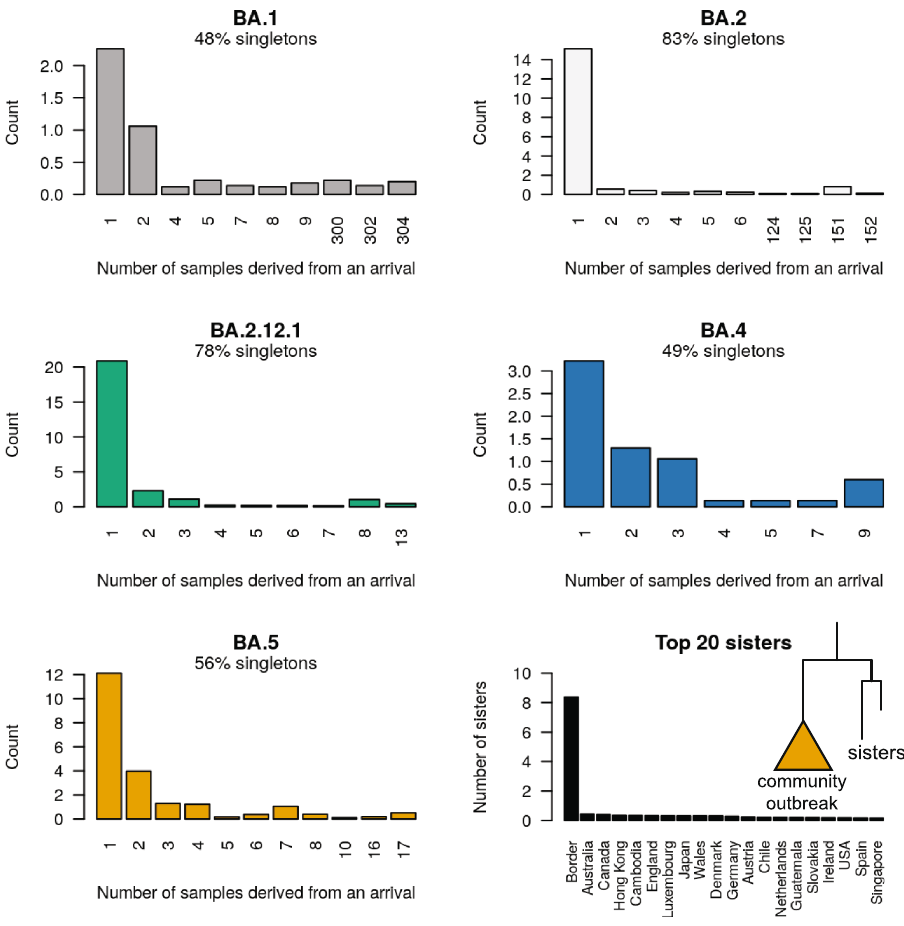
Fig.4|Posteriordistributionofsamplecount(i.e.treeleafcount;orcladesize) resulting from each introduction event. Many of these introductions were sin- gletons and did not lead to any detected secondary infection. Bottom right: the